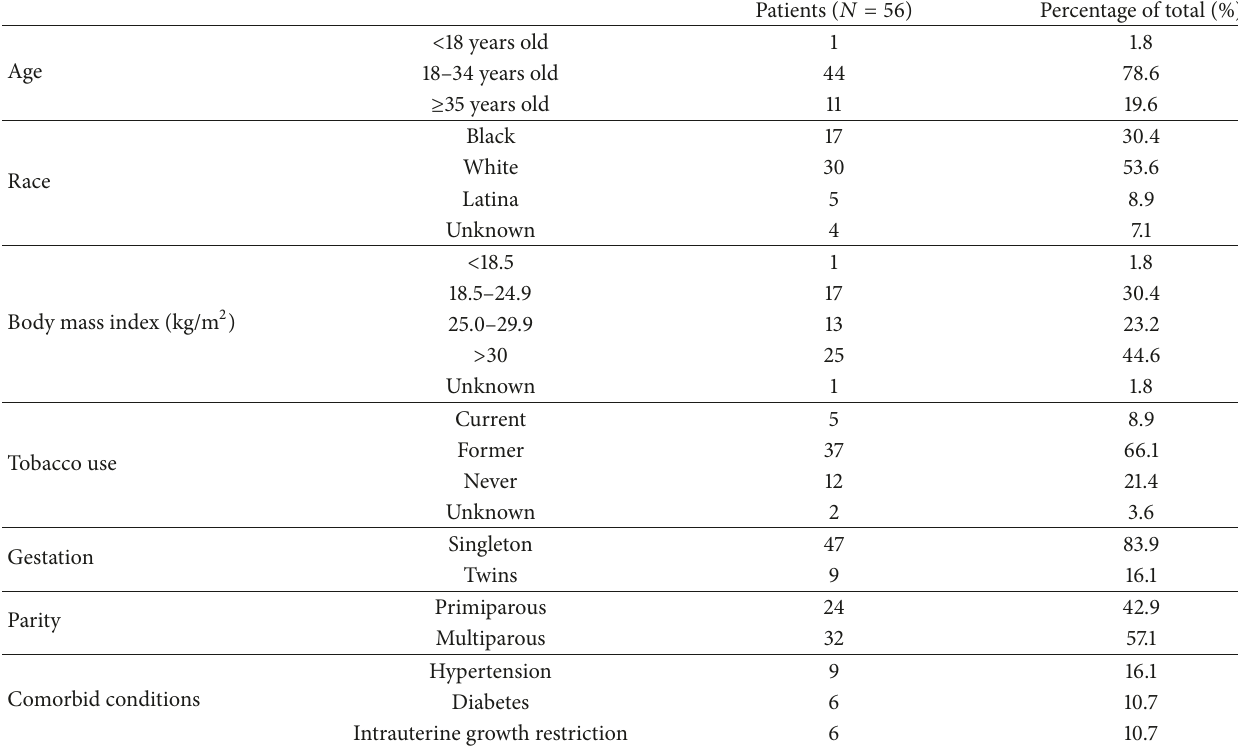
Table 1: Demographic profile and antenatal